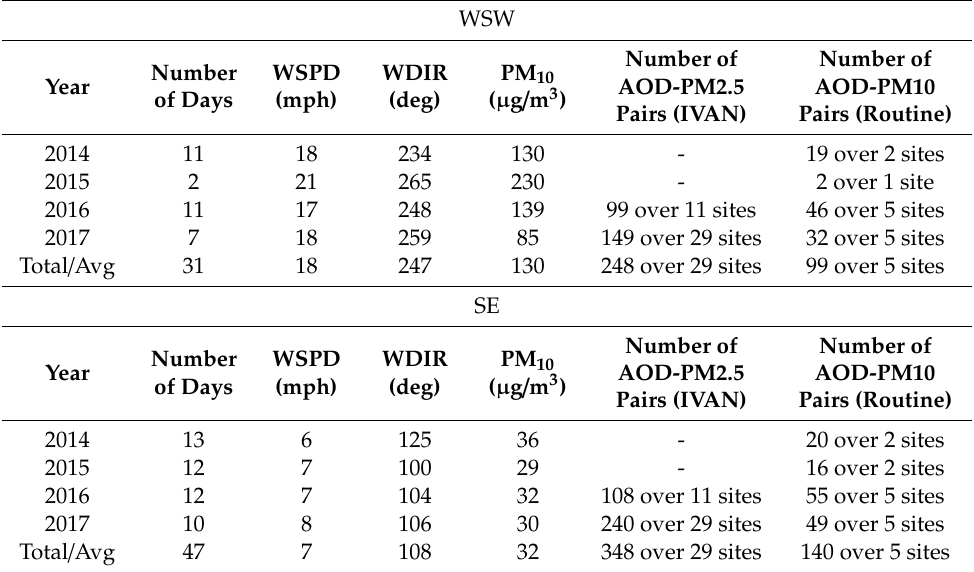
Table 2. Data summary and detailed